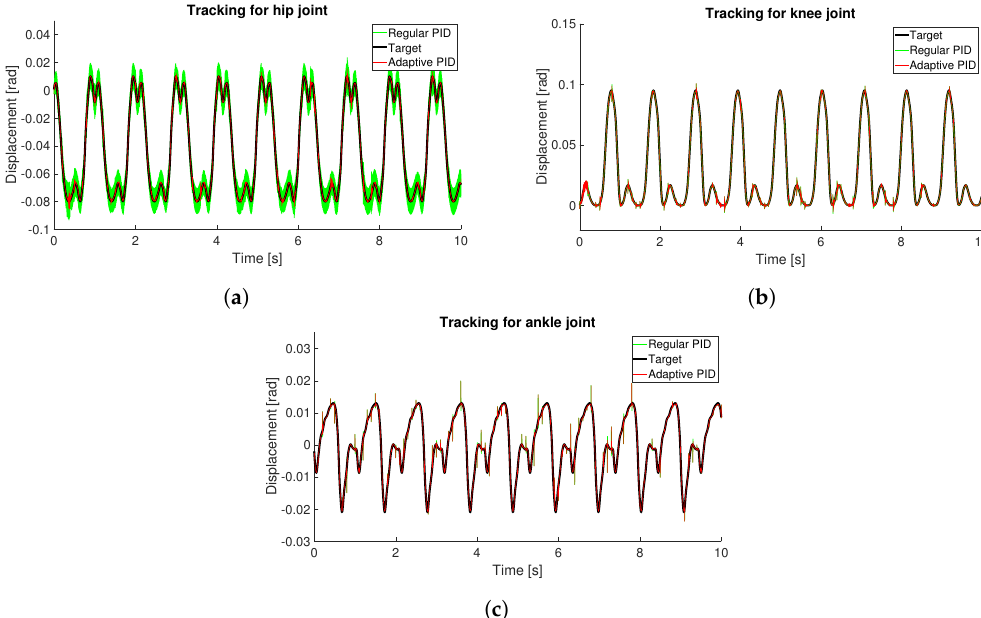
Figure 2. Position tracking for each joint, comparing the proposed adaptive controller (red) scheme with a regular PID controller (green) for the hip ( a ), knee ( b ) and ankle ( c